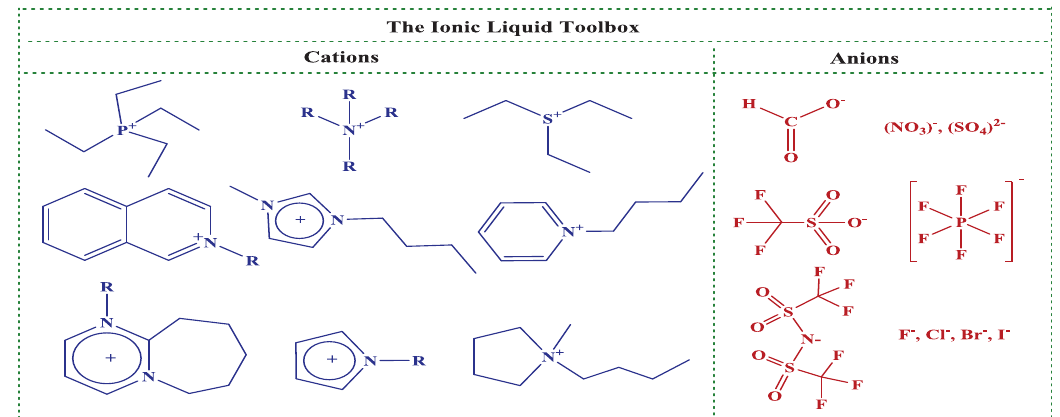
Scheme 1. The ionic liquid toolbox: important model cations and anions for